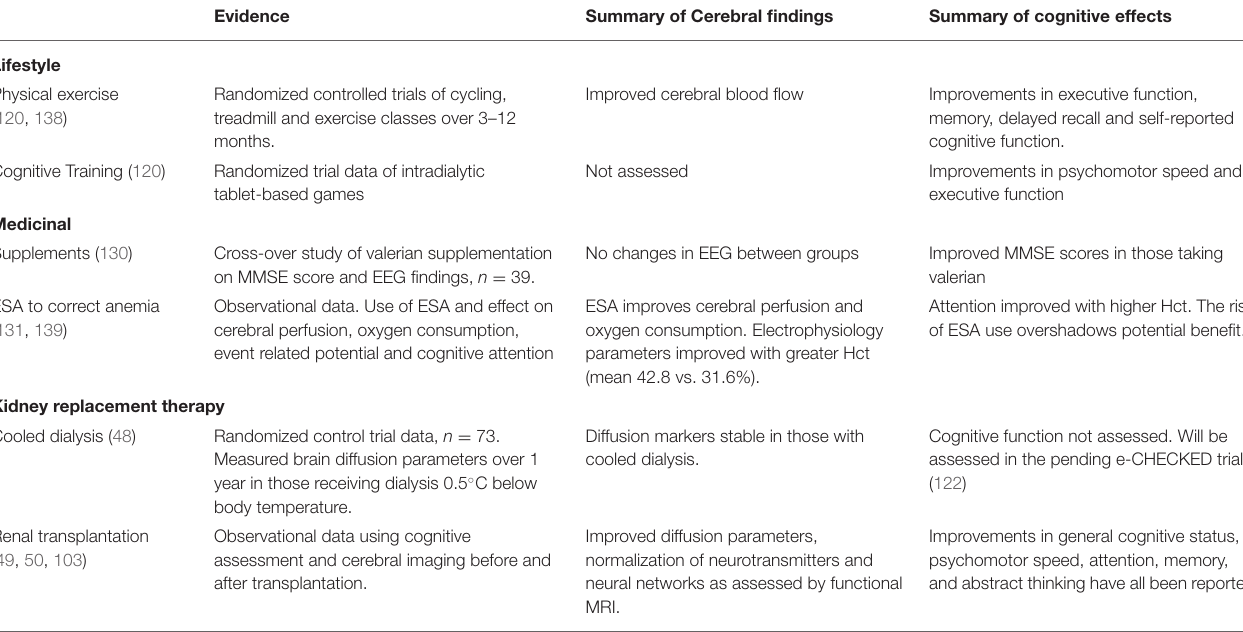
TABLE 2 | Evidence, cerebral effects, and cognitive effects of treatment strategies to improve or slow cognitive decline in